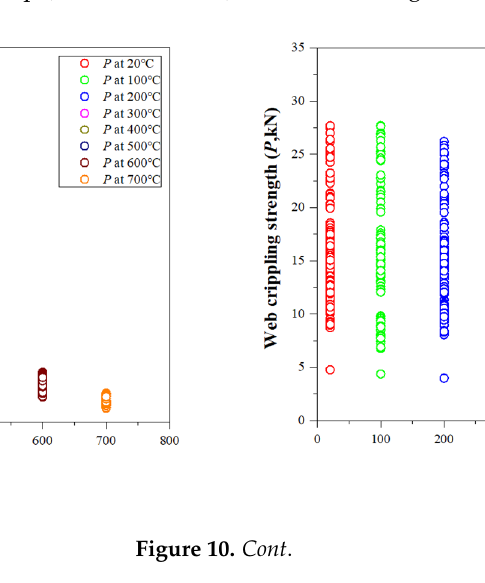
( d ) Figure 10. Web crippling strength against temperatures for cold-formed steel channel with ( a ) offset web hole and fastened flanges subjected to IOF; ( b ) offset web hole and unfastened flanges subjected to IOF; ( c ) centered web hole and fastened flanges subjected to IOF; ( d ) centered web hole and unfastened flanges subjected to IOF. 6. Proposed Design Equations and Reliability Analysis The previous study showed that the FEA model was able to predict the web crippling strength of perforated CFS channels with more precision than the existing design guide- lines. As a consequence of the FEA results, design equations in the form of web crippling strength reduction factors were proposed. The limits of the proposed equations are h/t ≤ 160, N/t ≤ 120, N/h ≤ 0.75, and a/h ≤ 0.8. 6.1. Design Equations The FEA results of parametric analysis were used to propose design equations for CFS channels with unfastened and fastened flanges when loaded with IOF loading. The proposed equations included the variables, such as a/h , x/h , and N/h . Regression analysis was performed to develop these equations (Equations (2) and (3)) as shown below: For CFS sections with centered holes: ' (2) For CFS sections with offset holes: